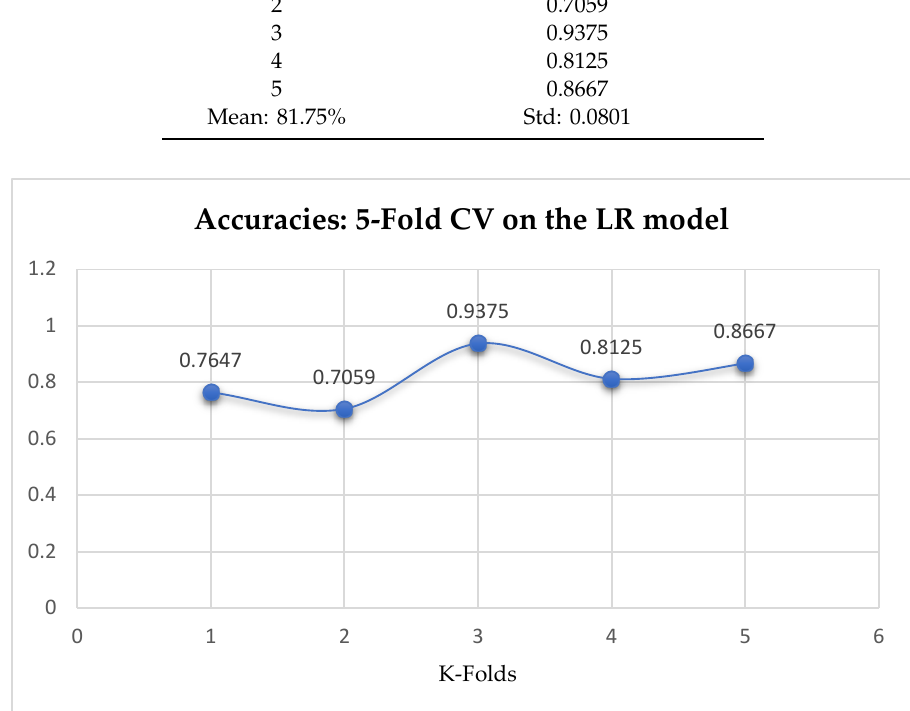
Figure 15. The accuracies achieved by the Folds after performing 5-Fold Cross-Validation on the LR model. Table 2. Accuracies achieved by performing 10-Fold Cross-Validation on the LR model.